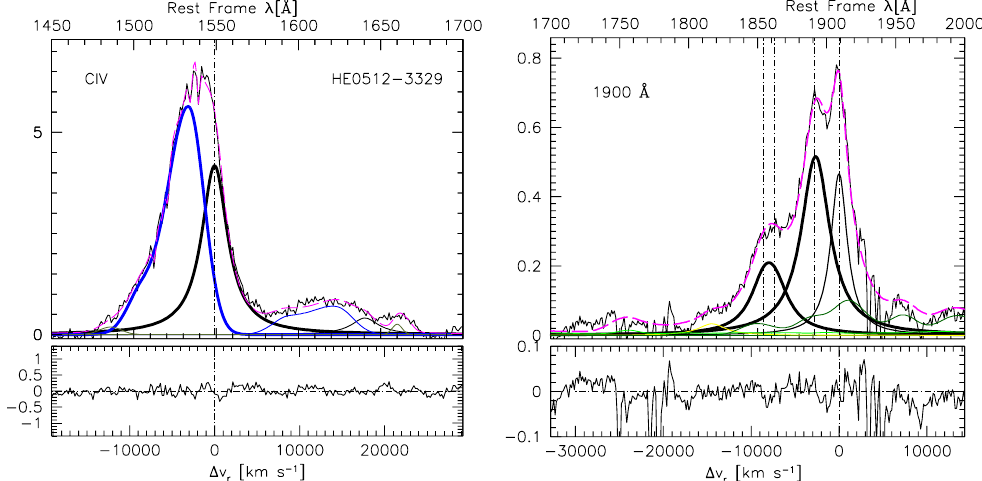
Figure 1. Left : the CIV profile of HE0512, a Population A quasar in the sample of Sulentic et al. [14]. The profile has been decomposed into a symmetric, unshifted component (the virialized component, thick black line) and a blue shifted component modeled by a skewed Gaussian (thick blue line). The flat-topped emission on the red side of CIV is mainly HeII λ 1640; Right : the 1900 blend for HE0512. The AlIII and SiIII] lines at 1860 Å and 1892 Å are unshifted and symmetric, and their FWHMs are in agreement with the H β and of the CIV virialized component profile. The thick black components can be thought as scaled H β profiles, as in the case of CIV. Note that AlIII λ 1860 lacks the blue-shifted excess of CIV. The thin line shows the CIII] λ 1909 profile whose intensity remains highly uncertain because of the heavy blending with FeIII